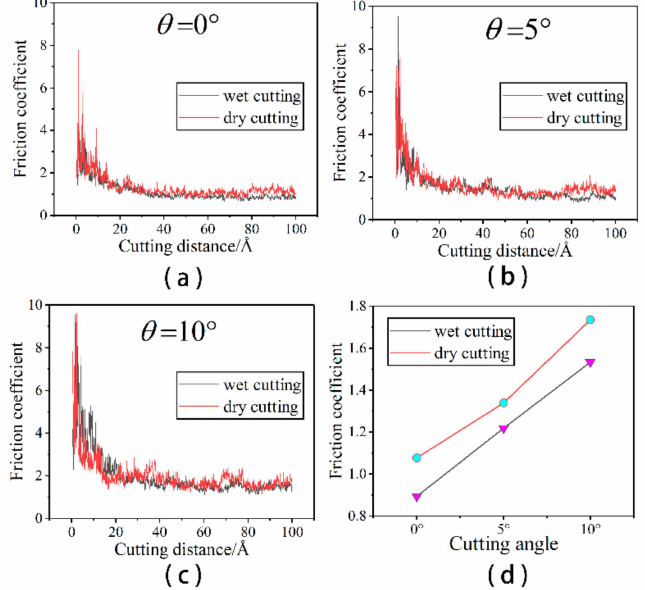
Figure 5. The change of friction coefficient. ( a ) θ = 0 ◦ ; ( b ) θ = 5 ◦ ; ( c ) θ = 10 ◦ ; and ( d ) comparison of friction coefficient during wet and dry cutting at various cutting